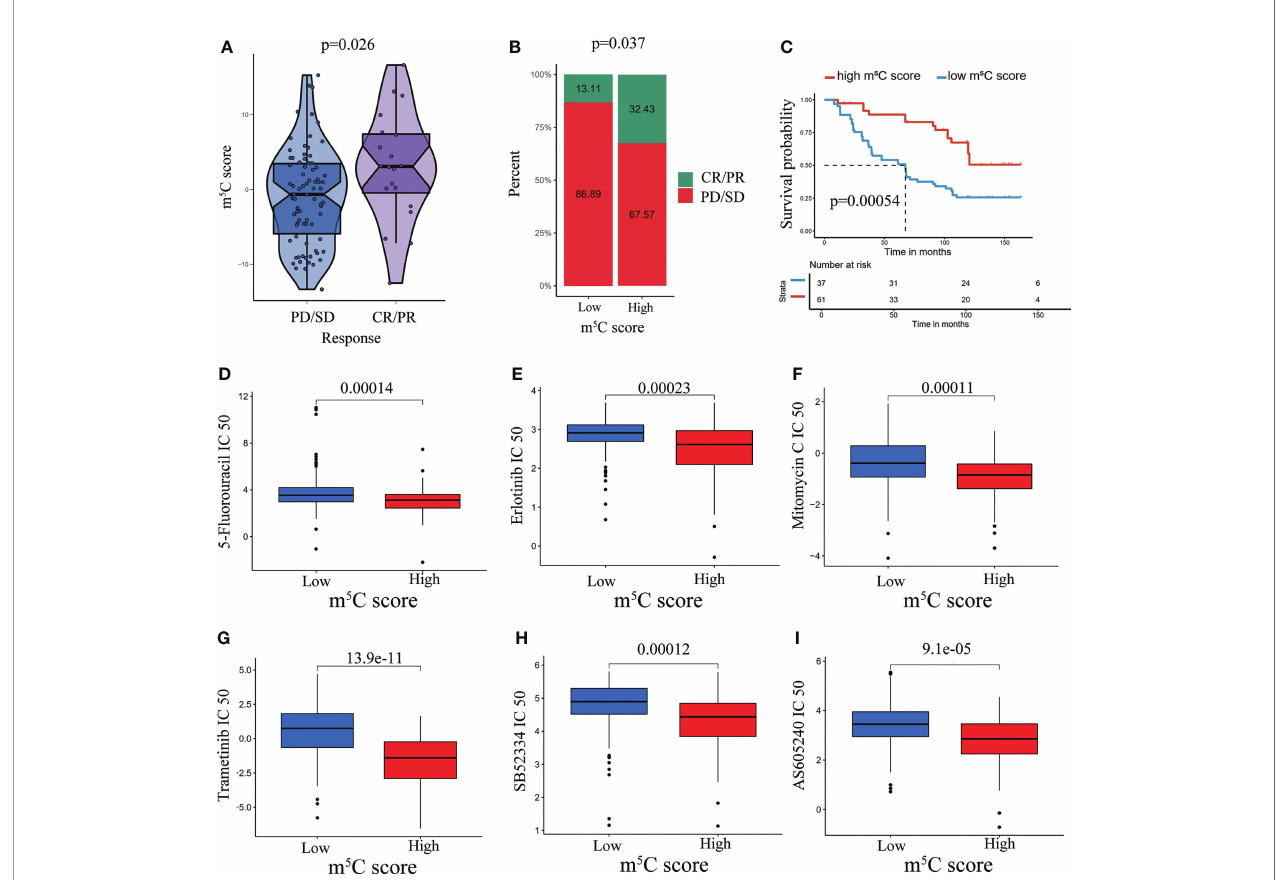
FIGURE 7 | Performance of the m5C score in predicting immunotherapy response and chemotherapy response. (A) Violin plots depicting the differences in the m5C score between the CR/PR and SD/PD groups in the GSE91061 cohort. (B) Rate of clinical response (complete response [CR]/partial response [PR] and stable disease [SD]/progressive disease [PD]) to anti-PD-1 immunotherapy in the high and low m 5 C score subgroups in the GSE91061 dataset. (C) Kaplan – Meier curves for patients with high and low m5C score in the GSE91061 dataset. (D – I) Prediction of chemotherapy agent response in high and low m5C score